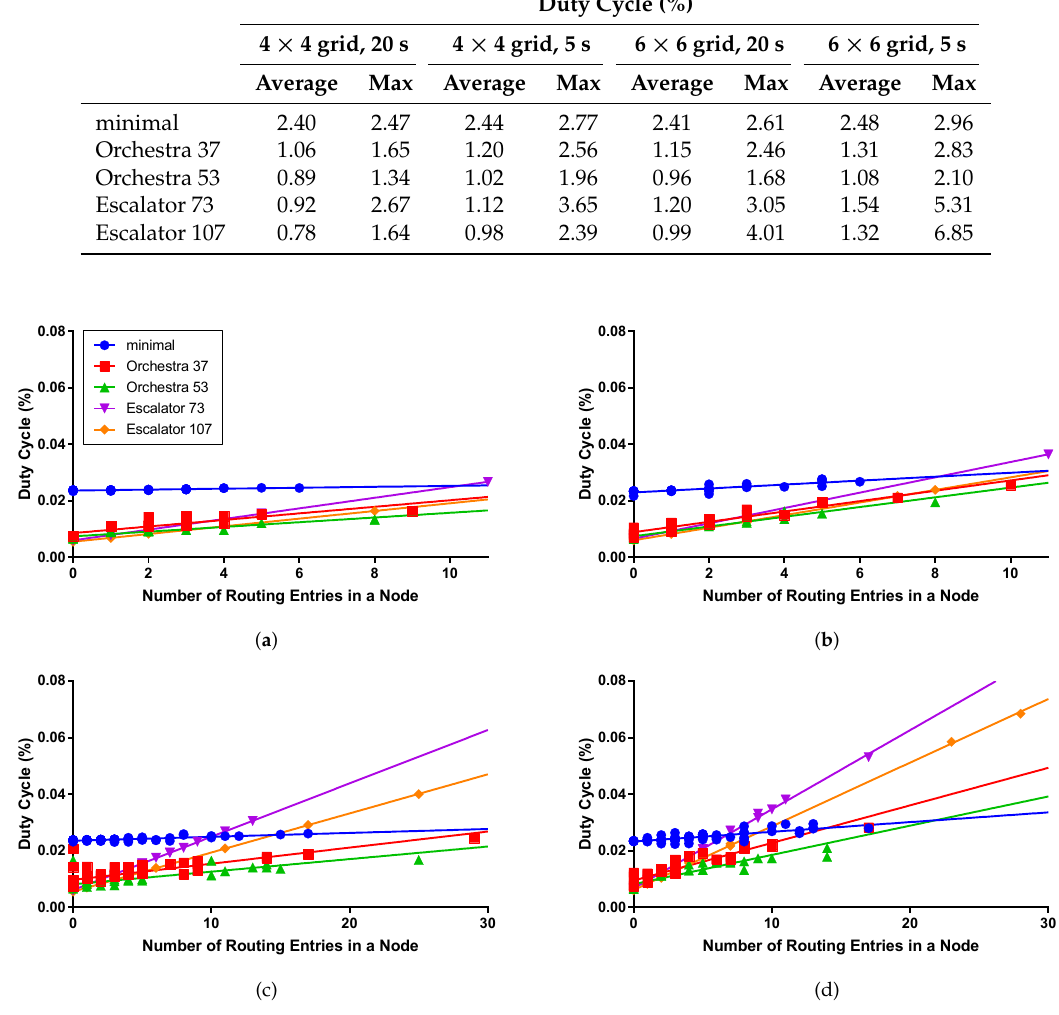
Figure 13. Duty cycle per number of routing entries in a node: ( a ) a packet transmission interval of 20 s on the 4 × 4 grid; ( b ) a packet transmission interval of 5 s on the 4 × 4 grid; ( c ) a packet transmission interval of 20 s on the 6 × 6 grid; ( d ) a packet transmission interval of 5 s on the 6 × 6